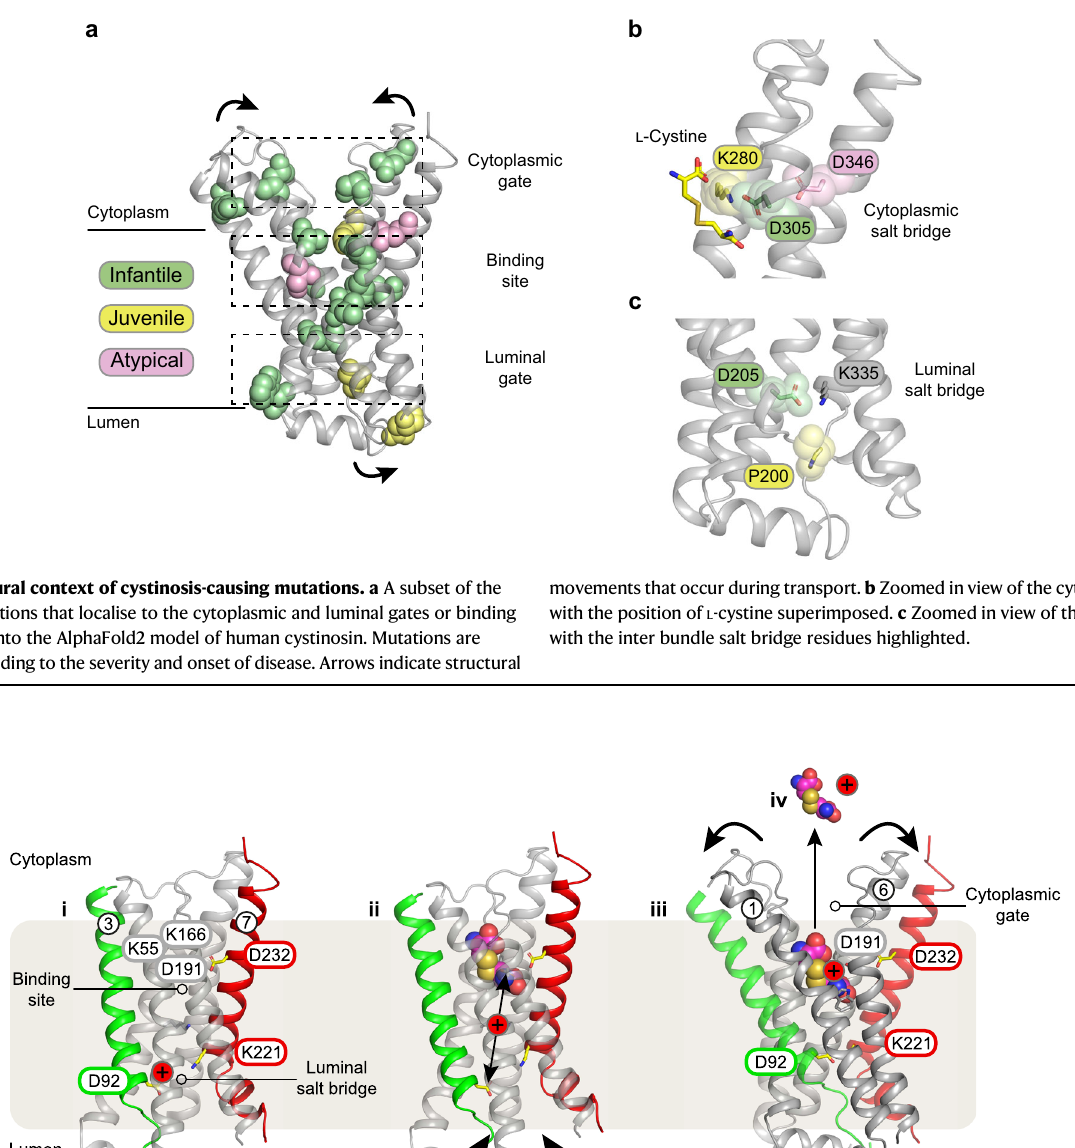
Fig. 6 | Conserved salt bridge interactions mediate L -cystine transport. Pro- posed mechanism for proton coupled cystine transport via cystinosin. i in the apo statethetransporteradoptsanoutwardopenstateduetoprotonationofAsp92on TM3. ii cystinebindingresultsindeprotonationofAsp92andpromotesopeningof the cytoplasmic gate through interactions within the binding site, with Asp191, Lys55 and Lys166 playing important roles in ligand recognition. Closure of the luminal gate is facilitated through a salt-bridge interaction between Asp92 and